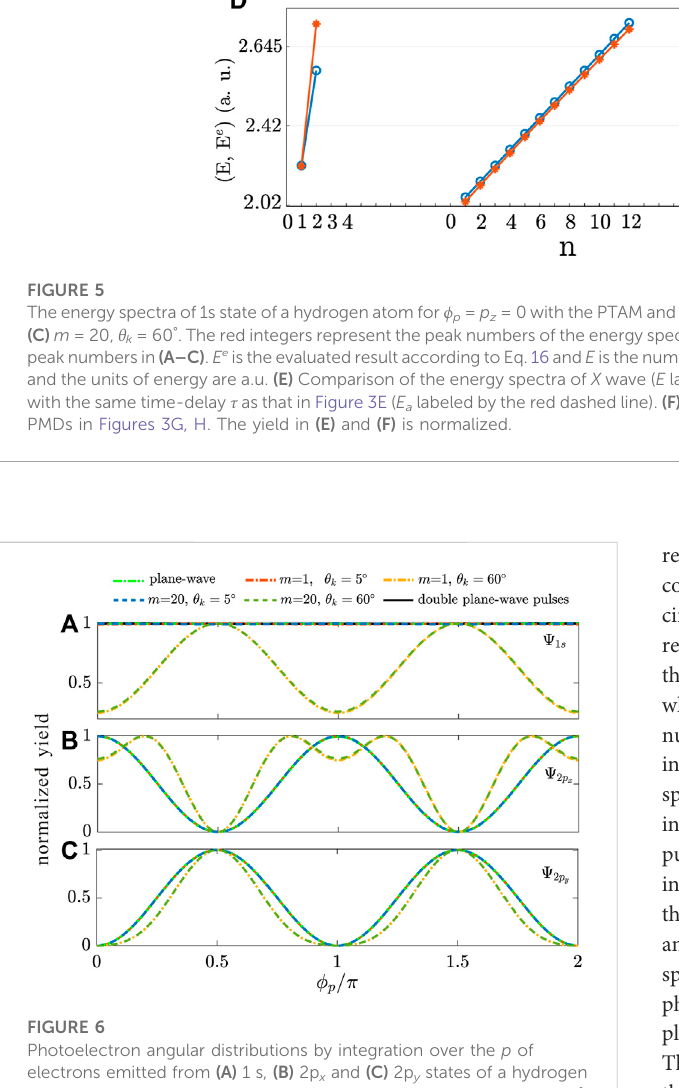
1s orbital as an example to verify that our theoretical model can precisely describe the interference fringes in the radial direction of PMDs. The energy spectra for Figures 3B,F,4F are plotted in Figures 5A – C. For ease of comparison with the evaluate results, the interference fringes are numbered. For the time-delay τ = 0.142 T L 0 , 1.302 T L 0 and 1.296 T L 0 presented in Figures 3B,F,4F